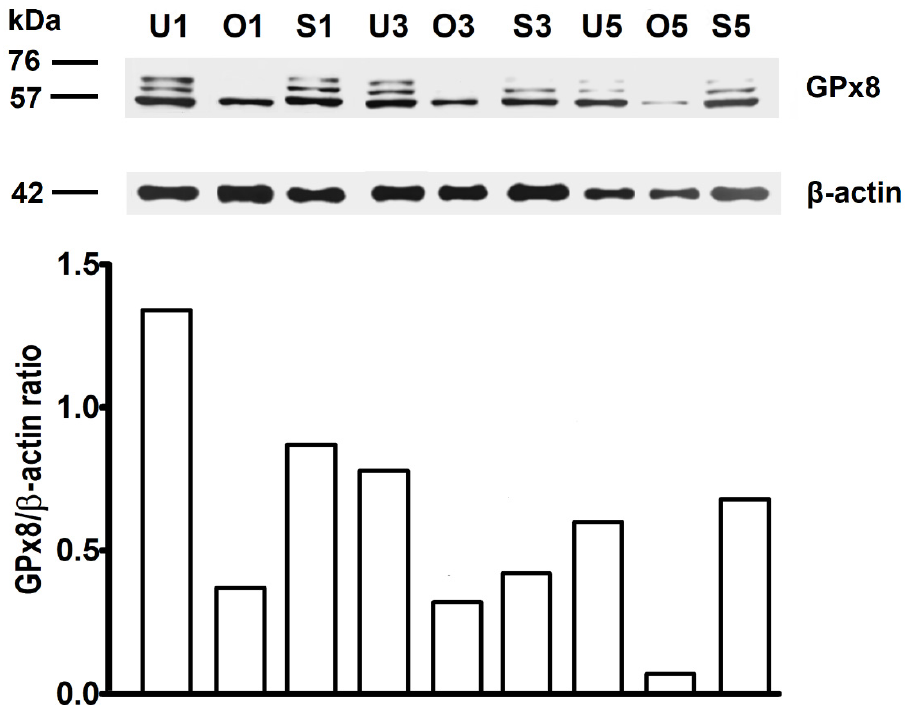
Figure 5. Western blot analysis of GPx8 amount in rat ovary (O), salpinx (S), and uterus (U). The number after the letter means the day of pregnancy. The main band of protein was detected at approximately 57 kDa in all examined organs. Moreover, in salpinx and uterus, two additional bands of higher size were detected. Densitometry, expressed as a ratio of GPx8 to β -actin, revealed that the highest amount of GPx8 enzyme was on D1 in the ovary (0.37), salpinx (0.87), and uterus (1.34). The amount of GPx8 in the ovary linearly decreased from D3 (0.32) to D5 (0.073) and similarly in the uterus (from 0.78 on D3 to 0.60 on D5). On the other hand, the lowest amount of protein in salpinx was observed on D3 (0.42), while it slightly increased on D5 (0.68).